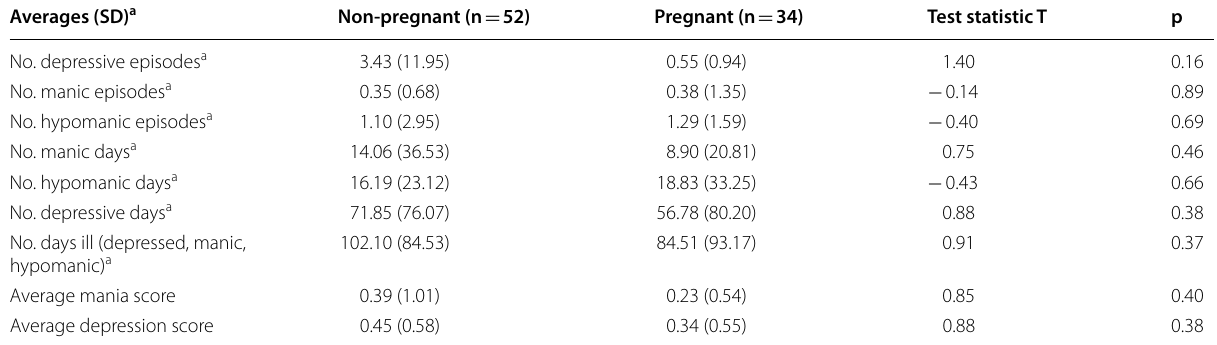
Table 3 Clinical lifechart results of non‑pregnant and pregnant women with BD recruited from two study cohorts from The Netherlands